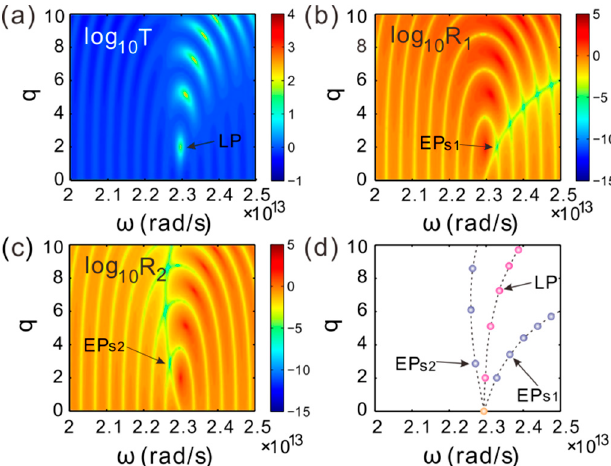
Figure 3. ( a – c ) The transmittance and reflectance varying with the gain–loss factor and angular frequency for light incident from the left and right, respectively. ( d ) Phase transition as the strength of gain–loss modulation increases from zero. Discrete splitting EPs are located at the blue dots. CPA-LPs are located at the purple dots.